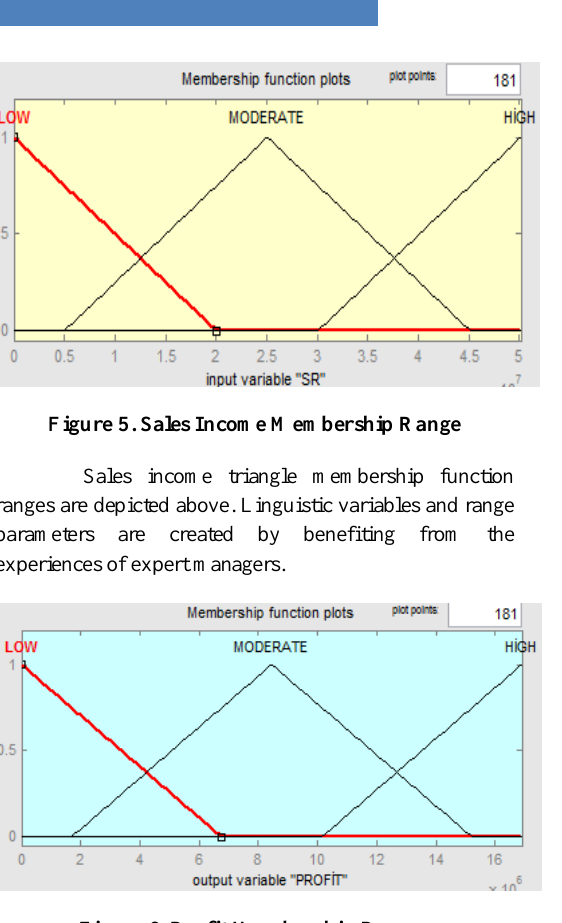
Figure 6. Profit Membership